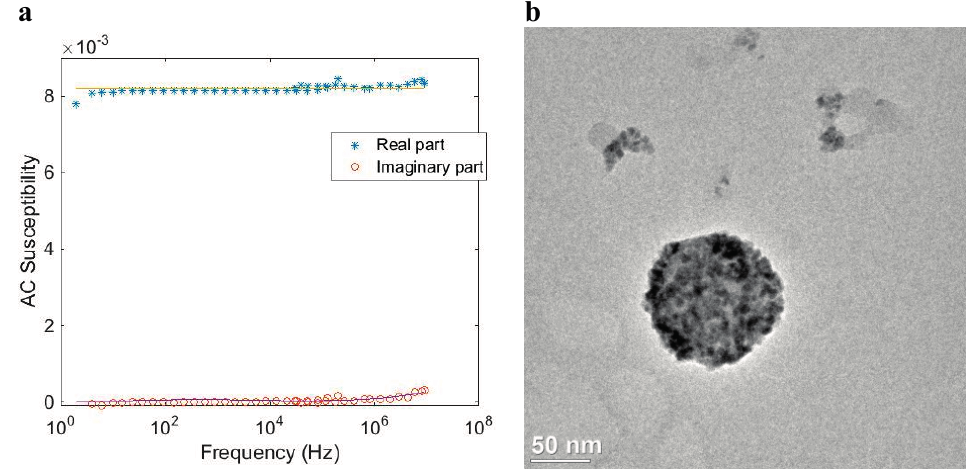
Figure 8. ( a ) AC susceptibility vs. frequency at room temperature of a magnetic multi-core particle system ( SP02 ) that shows fast Néel relaxation; ( b ) TEM image of the particle